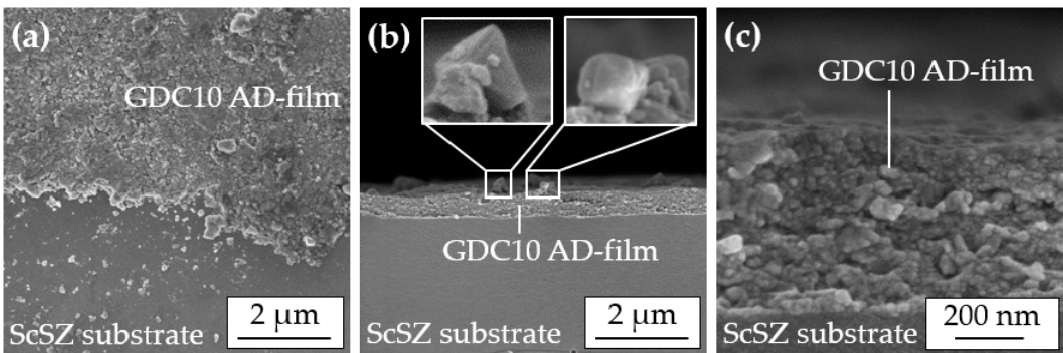
Figure 5. SEM images of a successfully sprayed GDC10 film using the tempered ( T PT = 1200 °C) and milled powder: ( a ) Top view near the edge of the coating and ( b ) fractured cross-section including loosely attached particles at the film surface (magnified inset); and ( c ) magnified film morphology.